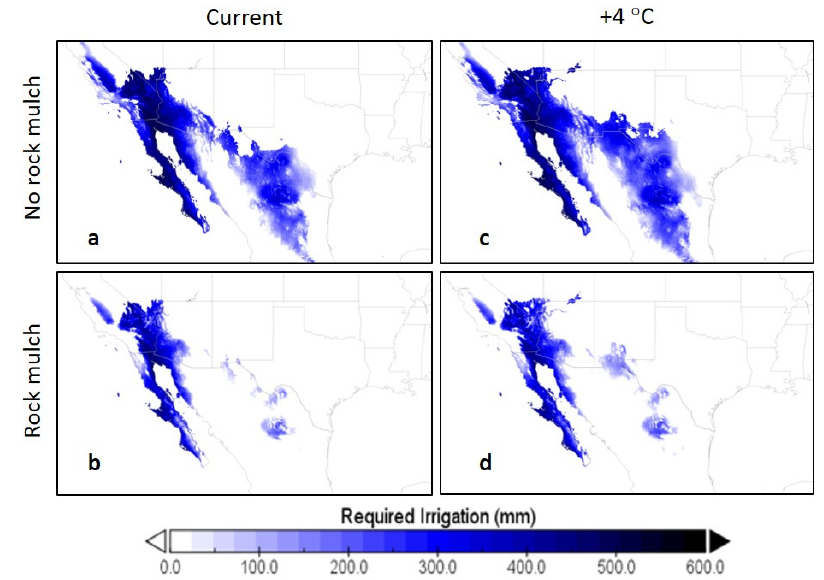
Figure 4. Irrigation required to achieve maximum production of Agave americana in the arid south- western US and western Mexico with recent climate ( a ), with +4 °C warming ( c ), with recent climate plus rock mulching ( b ), and with +4 °C warming plus rock mulching ( d ). The optimal irrigation amounts for maximizing biomass of A. americana are relatively low compared to the current irrigation amounts that are typical in southwestern states of